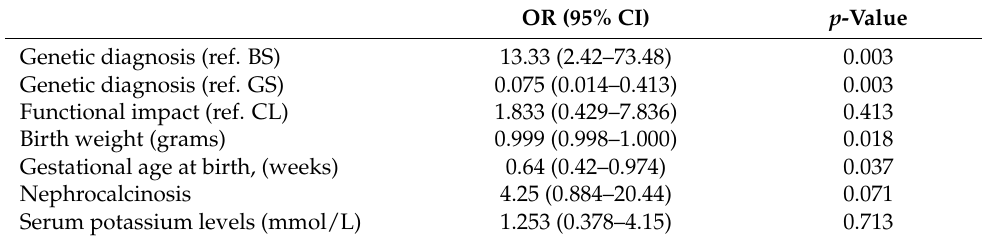
Table 4. Univariate analysis for CKD (crude odds